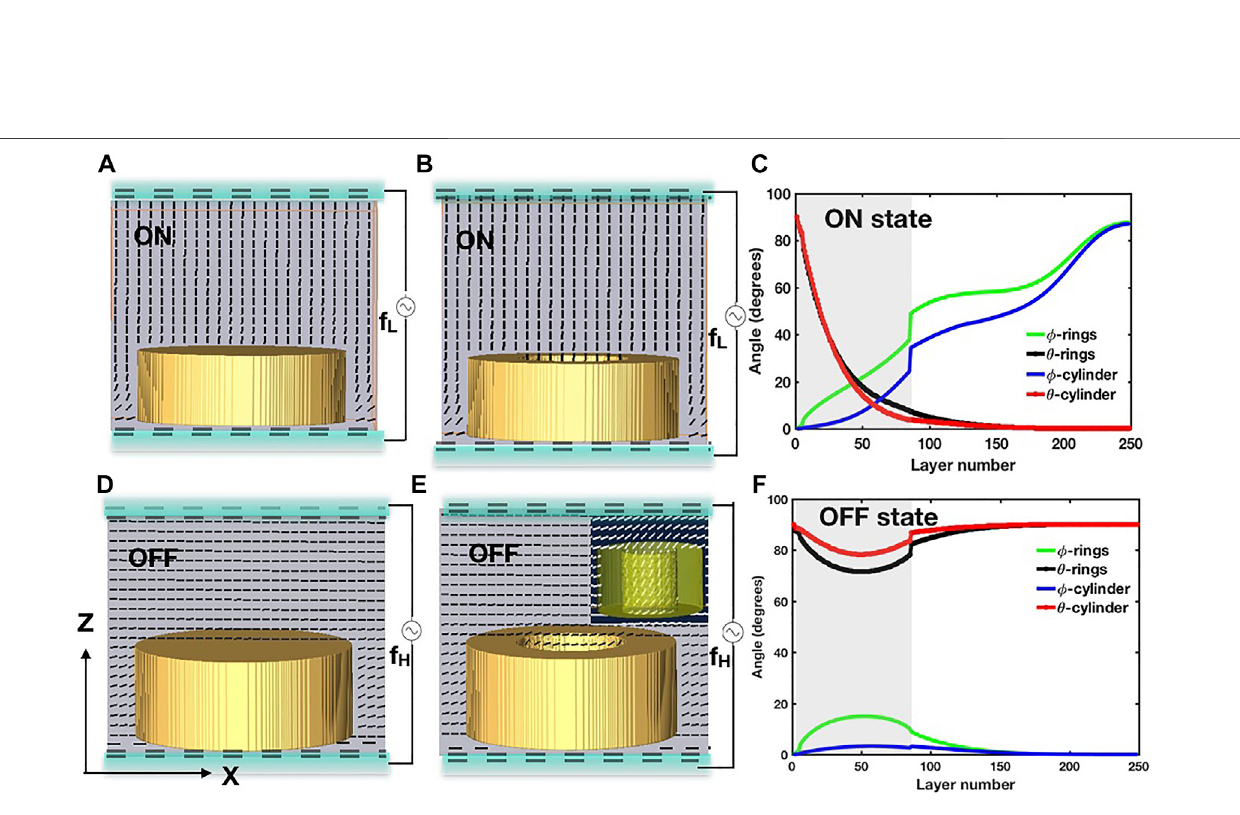
FIGURE 2 | Director con fi gurations of DFLC cell embedded with cylinders and cylindrical rings: (A,B) . Vertically aligned con fi guration (ON state) of DFLC cell with cylinders and cylindrical rings at f L = 10 KHz (V = 0). (C) Layer wise averaged director angles (cid:1) n ( x , z ) as a function of layer number for ON state. (D,E) Planar aligned con fi guration (OFF state) of DFLC cell with cylinders and cylindrical rings at f H = 100 KHz (V = 0). (F) Layer wise averaged director angles (cid:1) n ( x , z ) as a function of layer number for OFF state. Shaded areas in (C,F) represent the layers occupied by microstructures.